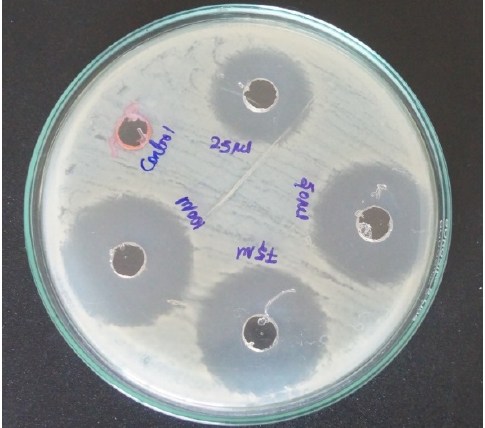
Figure 4. Antibacterial activity of selenium nanoparticles synthesized using D. indica on St. aureus (MTCC96).